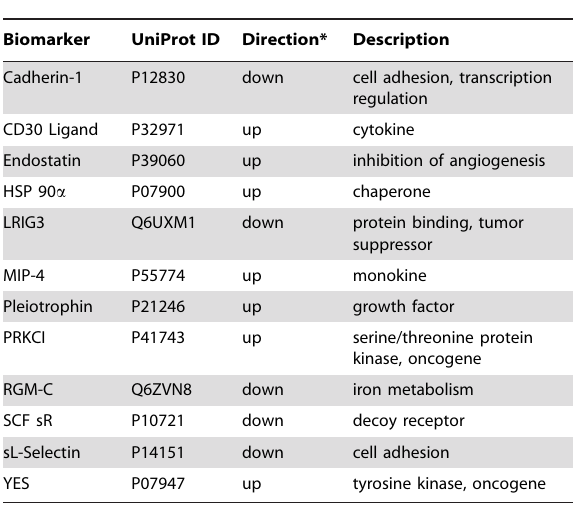
Table 7. Twelve biomarker classifier proteins 1